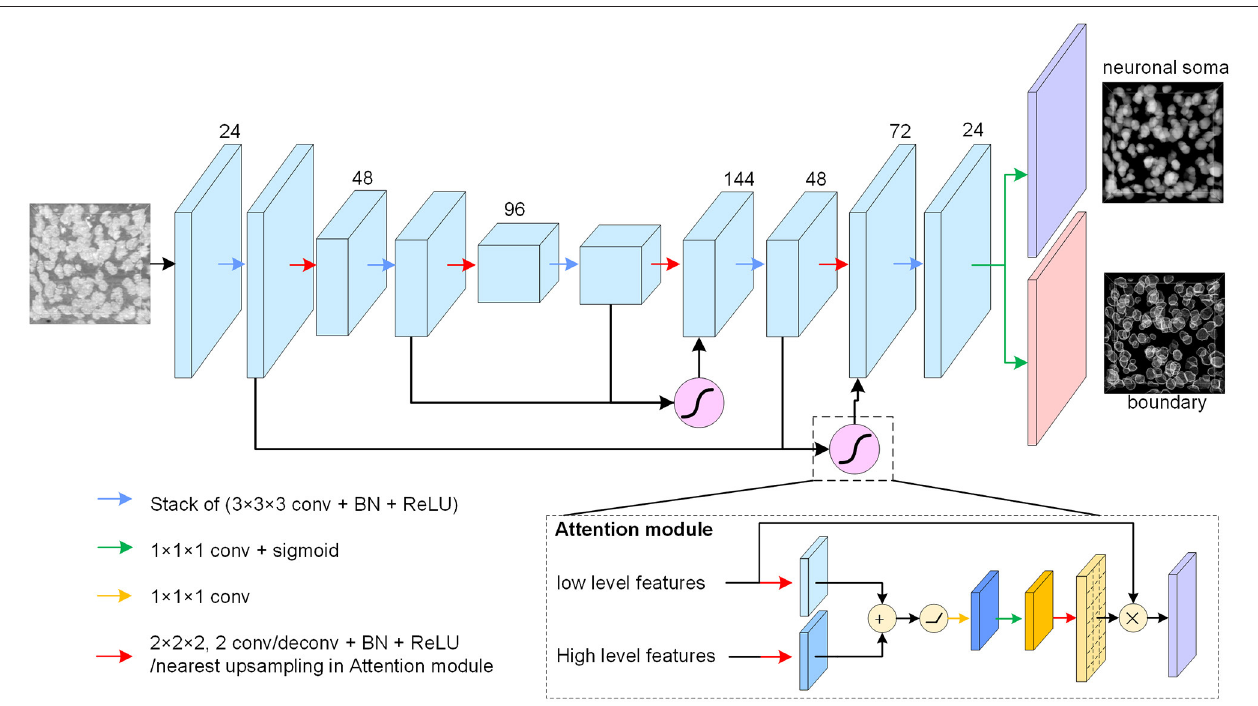
FIGURE 4 | Neuronal soma segmentation model. The blocks represent the feature maps. The violet and red blocks denote the two output branches of boundary and neuronal soma, and the purple module is the spatial attention module. The kernel size of the 3D convolutional layers is 3 × 3 × 3, and that of the prediction layer is 1 × 1 × 1. The root feature map number is 24. The black arrow indicates data flow, and the green and yellow arrows represent the 1 × 1 × 1 convolution layer with or without sigmoid activation, respectively. The red arrow represents the down-sampling or up-sampling layers in the CNN. The down-sampling layer is a convolution layer with a stride of 2, and the up-sampling layer is a deconvolution layer with a stride of 2. In particular, the up-sampling layer in the attention module is the nearest